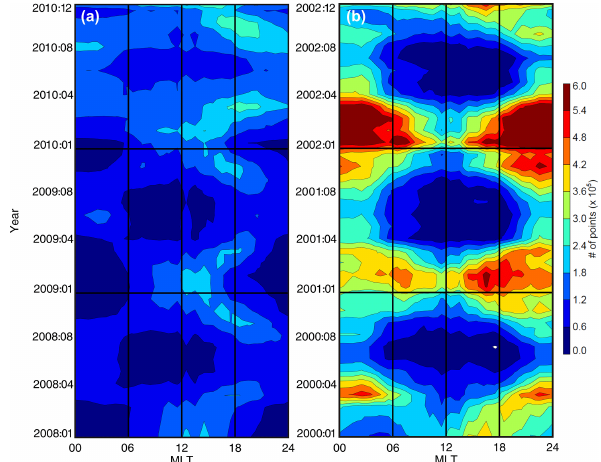
Fig. 7. Contour plot for the hourly-averaged number of grid points on individual 2min SuperDARN convection maps for periods of (a) minimum solar activity (2008–2010) and (b) maximum solar activ- ity (2000–2002) as a function of UT time. The white line is the con- tour with the number of points at 150 (both panels) and 200 (panel b ); in regions with a lower number of points a SuperDARN convec- tion map based on the data is expected to be globally